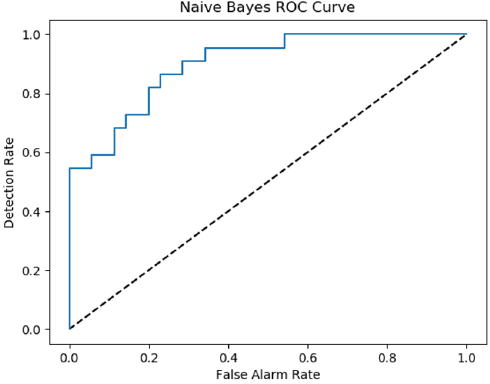
Figure 8. Walking paths in different